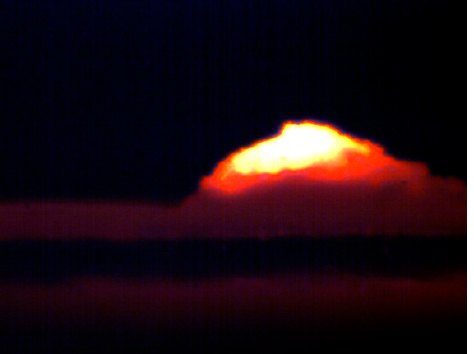
Figure 26. Image showing close-up combustion of a cluster of 10 µm aluminum powder dropped on a Ni-chrome ribbon preheated to ~1300 °C.